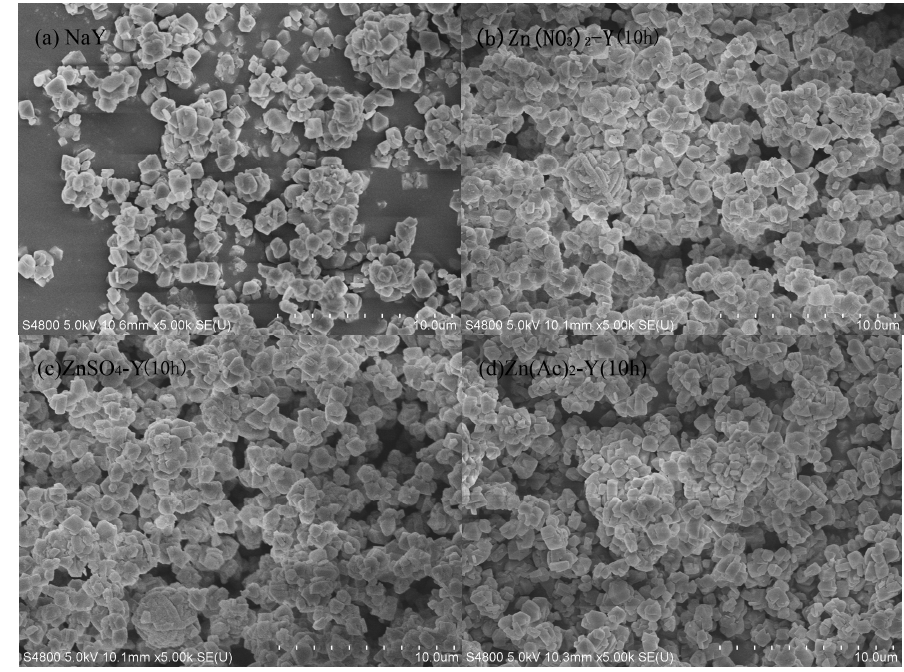
Figure 2. SEM images of adsorbents: ( a ) NaY; ( b ) Zn(NO 3 ) 2 -Y (10 h); ( c ) ZnSO 4 -Y (10 h); ( d ) Zn(Ac) 2 -Y (10 h).